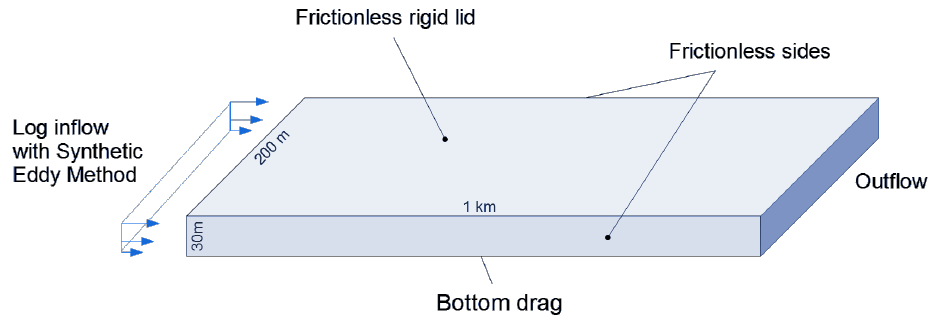
Figure 1. The idealised tidal channel, showing boundary conditions and